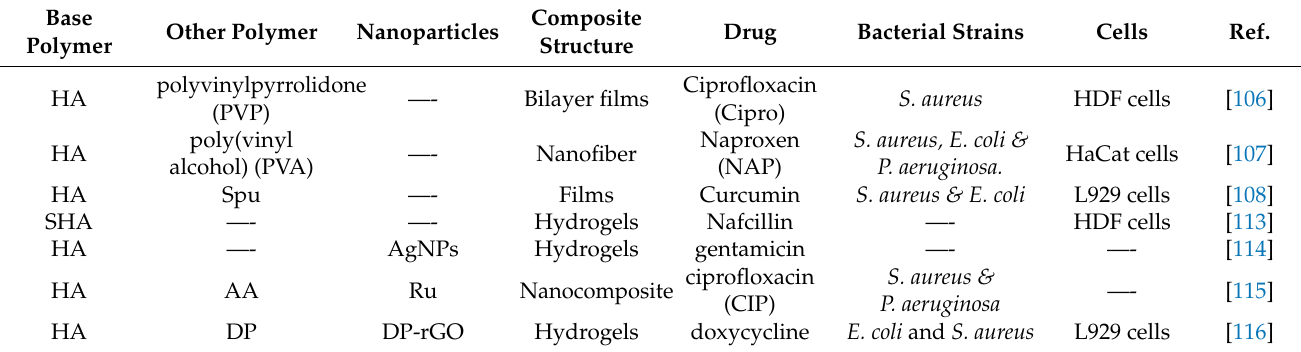
Table 4. HA-nanocomposite loaded with antibiotic drugs for wound healing